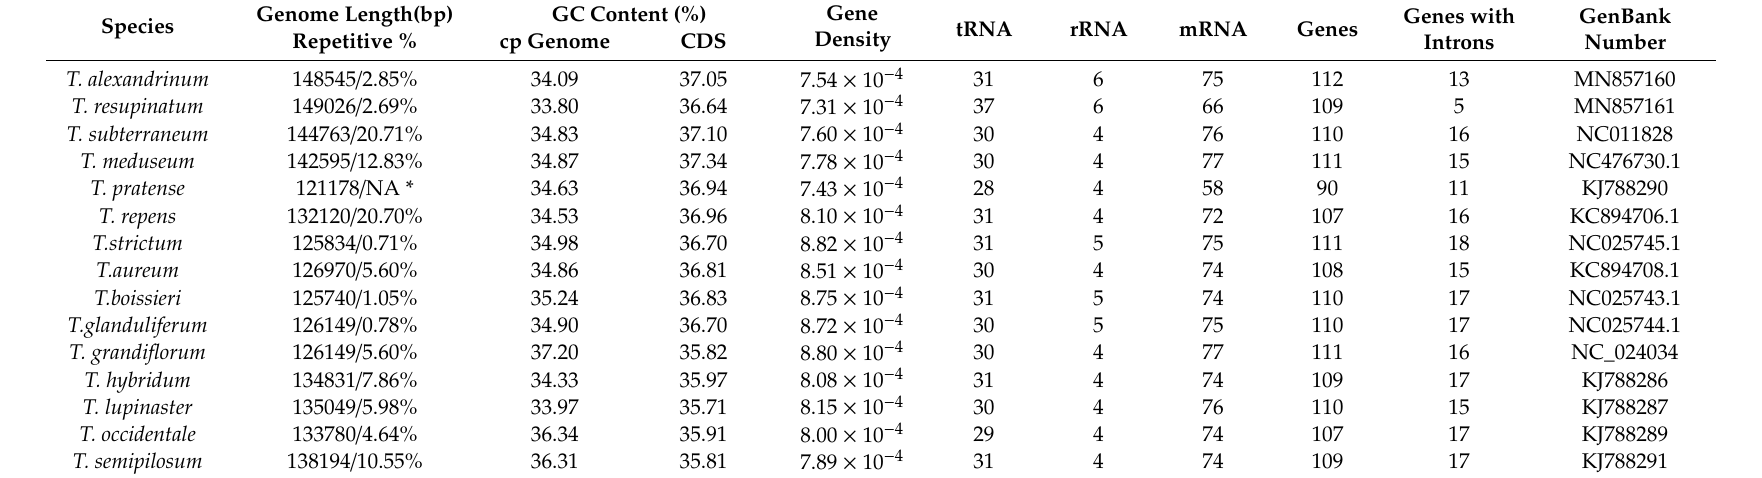
Table 1. Comparison of the fifteen Trifolium